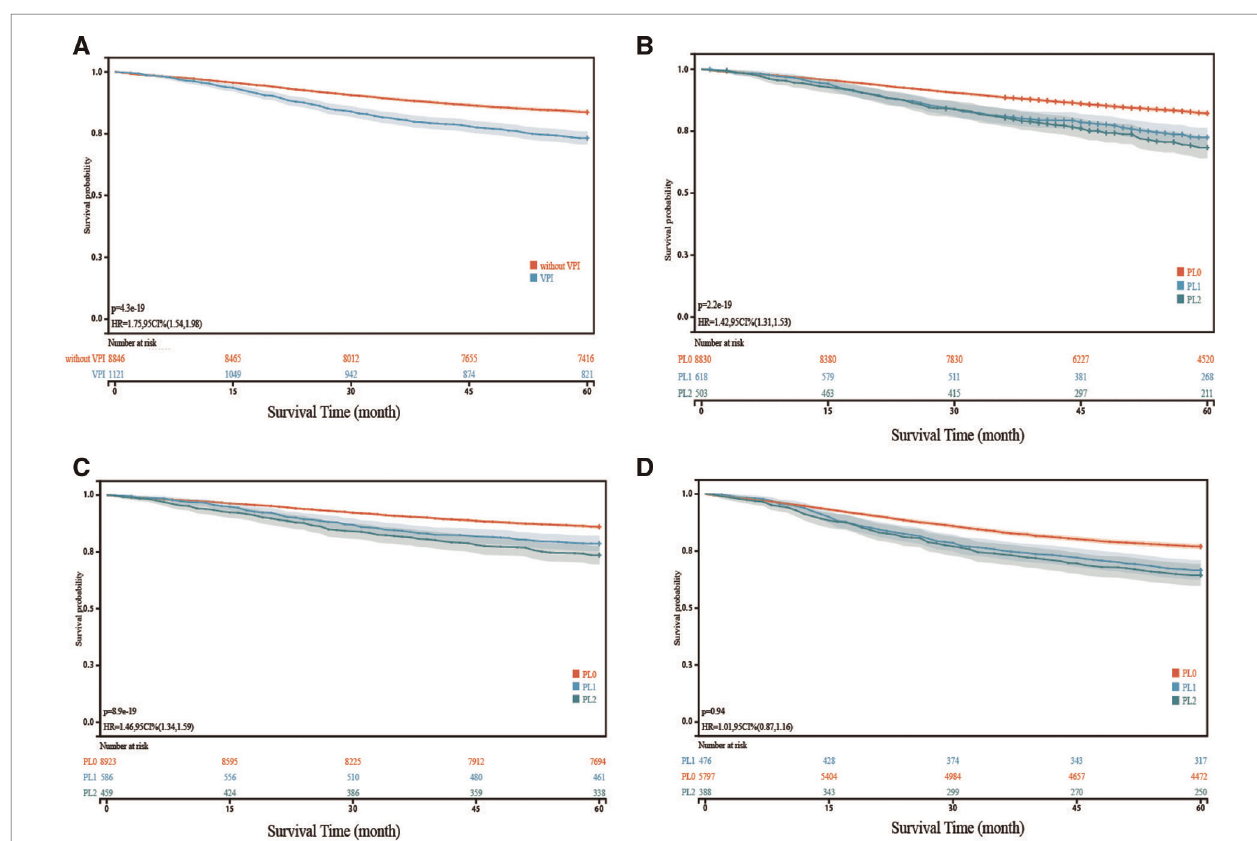
FIGURE 2 | Kaplan-Meier curve analysis (log-rank test) of lung cancer speci fi c survival (LCSS) in different cohorts VPI, visceral pleural invasion. ( A ): Comparison of LCSS of NSCLC with VPI and without VPI; ( B ): Comparison of LCSS of NSCLC with PL1 and PL2 with that of NSCLC without VPI; ( C ): In patients without lymph node metastasis, Comparison of LCSS of NSCLC with PL1 and PL2 with that of NSCLC without VPI; ( D ): In patients with lymph node metastasis, Comparison of LCSS of NSCLC with PL1 and PL2 with that of NSCLC without VPI Note: The survival time refers to lung cancer speci fi c survival